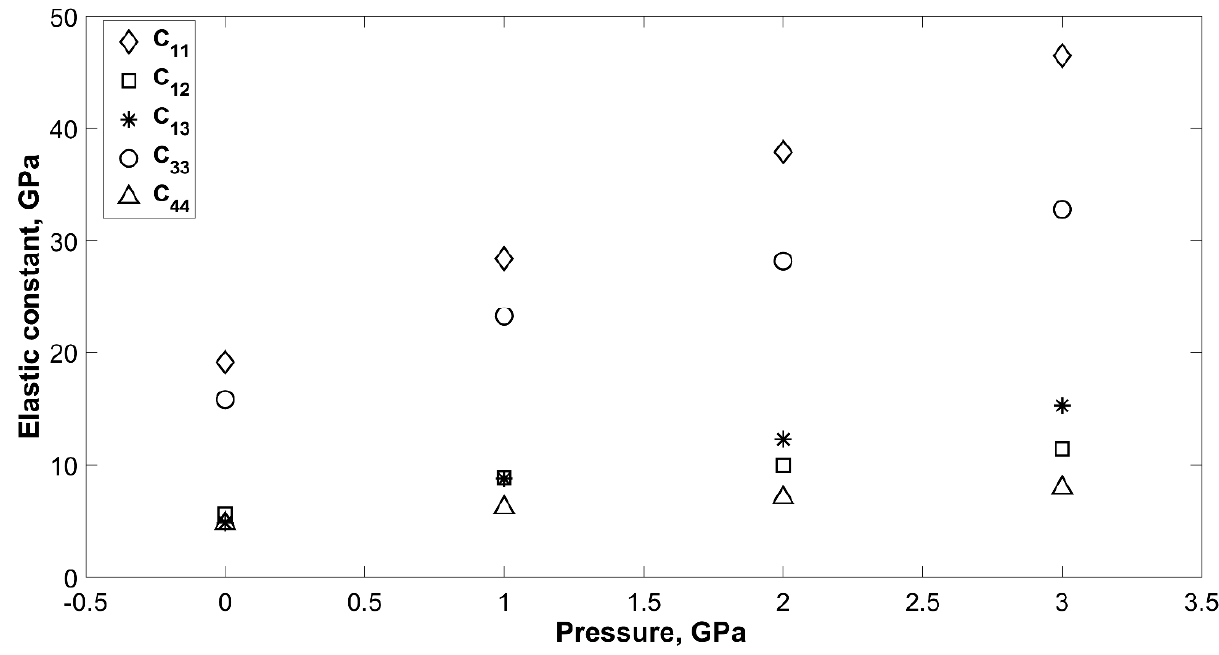
Figure 1. Pressure-dependent elastic constants of CO 2 -NH sH gas hydrate at 0 K. Table 2. Elastic constants (C αβ ) of empty and Xe-NH sH gas hydrates under pressure and at 0 K.